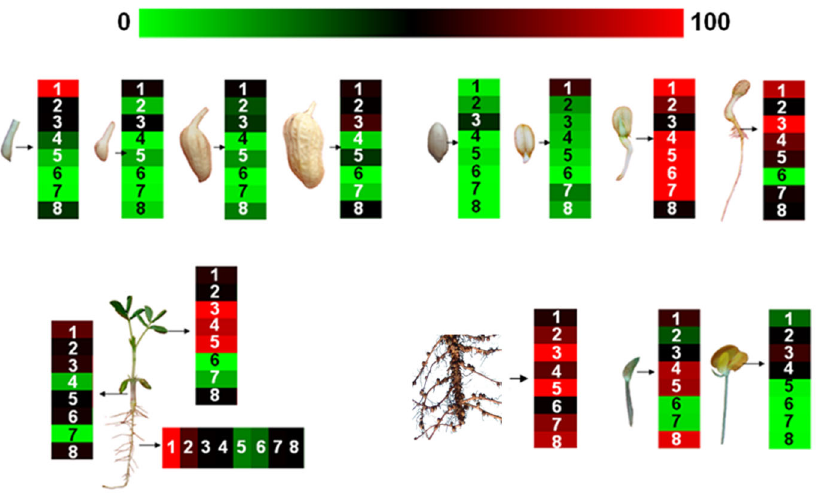
Figure 1. Expression patterns of peanut AhGLP s in various tissues/organs and developmental stages. Expression patterns of AhGLP s were examined in (A) developing pods at 1, 4, 15 and 35 days after penetration into soil, (B) seeds at 1 hour, 1, 3 and 5 days after germination, (C) roots, stems and leaves of 14-day-old seedlings, and (D) roots, flower buds and flowers during flowering. Transcript abundance detected using qRT- PCR was normalized to expression of actin gene. Numbers (1–8) inside boxes correspond to AhGLP1 , AhGLP2 , AhGLP3b , AhGLP4 , AhGLP5b , AhGLP6 , AhGLP7b and AhGLP8 , respectively. Expression levels are color-coded on the bottom bar. Green color indicates the down-regulation of gene expression, red color indicates the up-regulation of gene expression, black indicates the RNA levels